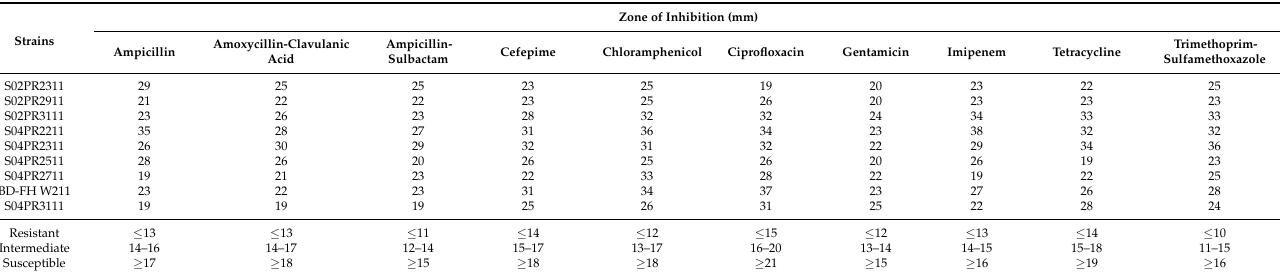
Table 2. Prevalence of antibacterial susceptibility in Vibrio vulnificus